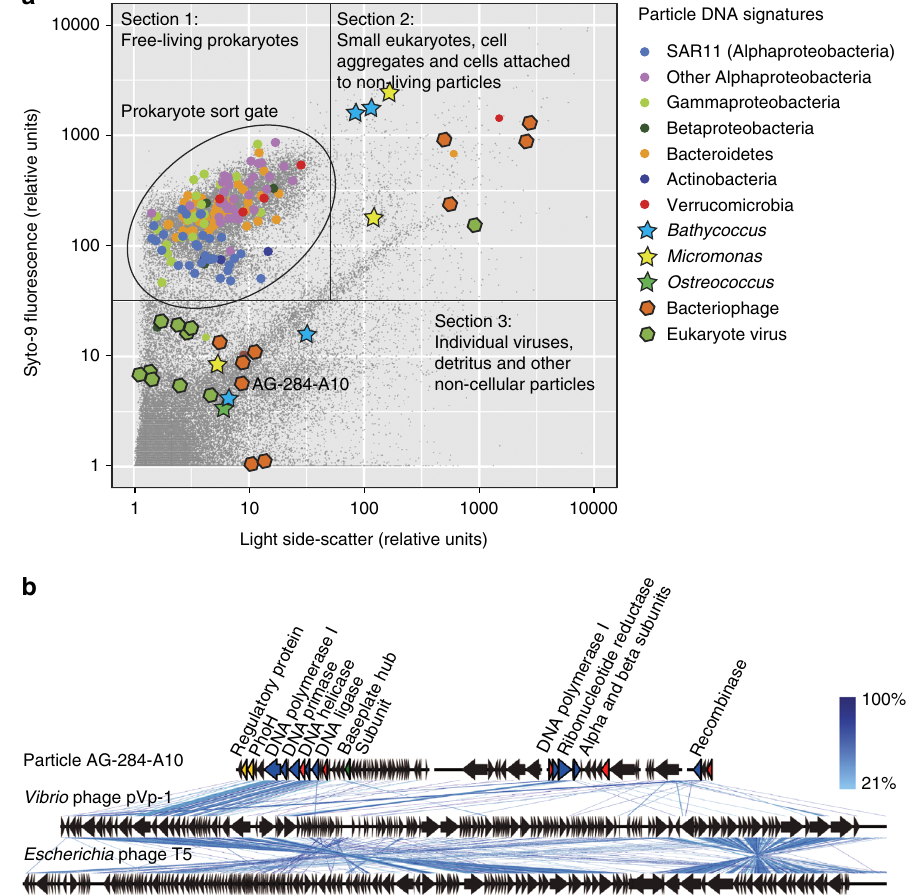
Fig. 4 Integration of index FACS and single-cell genomics. a Flow cytometry optical properties of individual marine prokaryotes and non-cellular particles from which SAGs were generated. Section boundaries indicate tentative separation of particle types. b Genome alignments of the individual viral particle AG-284-A10 and its closest sequenced relatives Siphoviridae Vibrio phage pVp-1 (Genbank #JQ340389) and Escherichia phage T5 (Genbank AY543070). Each arrow represents a gene in the direction of transcription. Arrows represent genes related to regulation ( yellow ), DNA replication ( blue ), structure ( green ), unknown phage proteins ( red ), and hypothetical phage proteins ( gray ). The scale bar in b indicates peptide-sequence